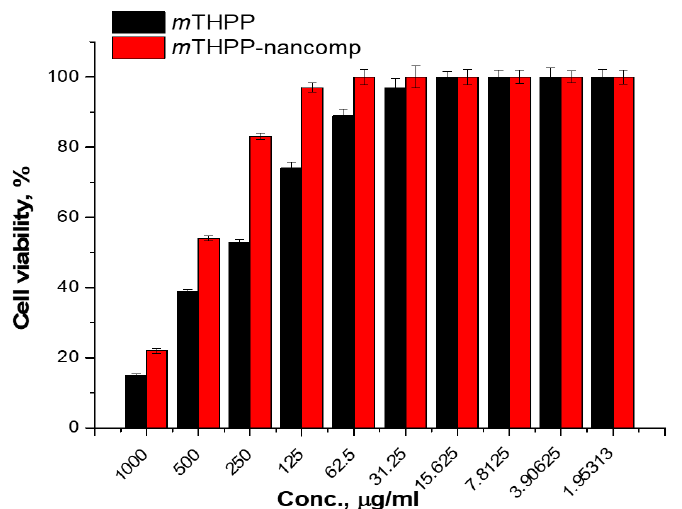
Figure 7. Cytotoxicity of m THPP and m THPP-loaded nanocomposite against a Vero normal cell line.